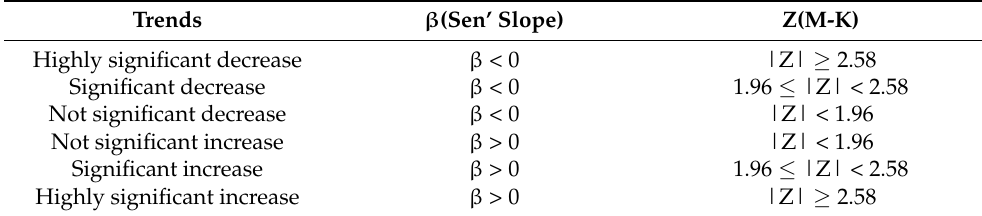
Table 3. Significance of changing